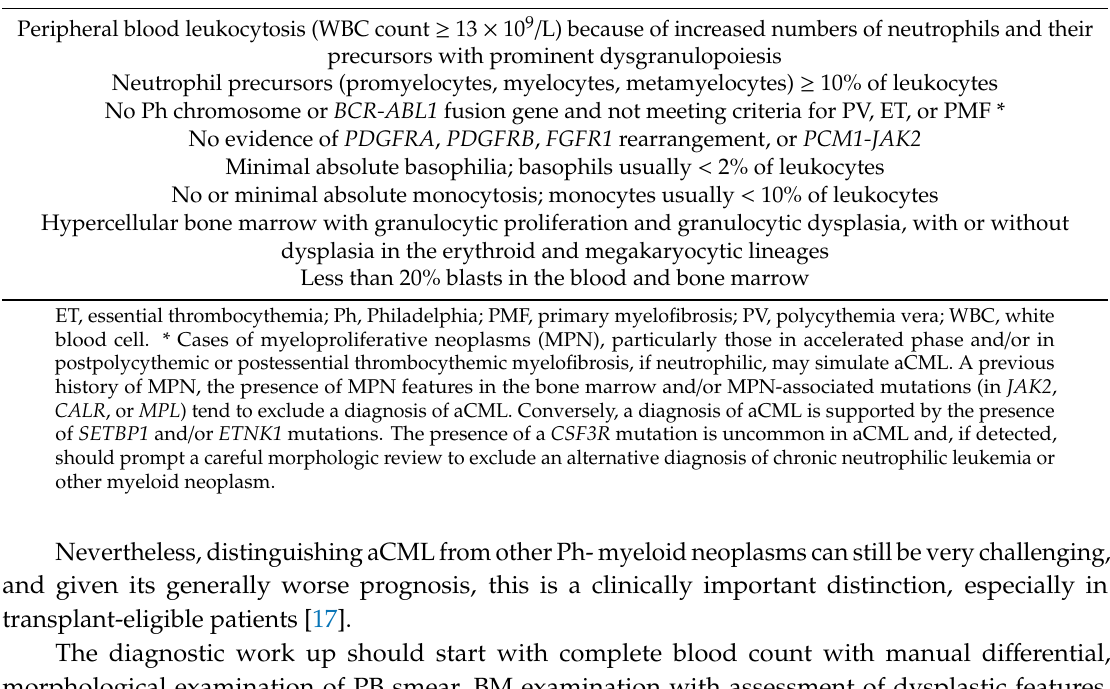
Table 2. WHO 2016 Diagnostic Criteria for atypical chronic myeloid leukemia (aCML) [4]. WHO 2016 Diagnostic Criteria for